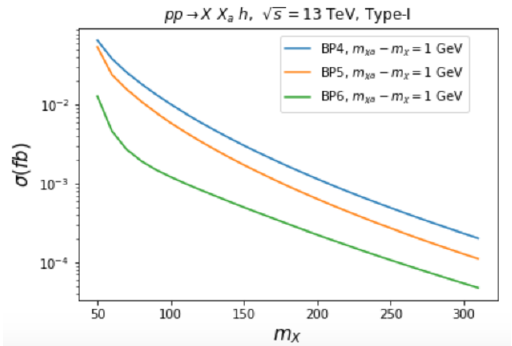
Figure 12 . Cross sections for (cid:31)(cid:31) a h (cid:12)nal state as a function of DM mass for benchmark points BP4, BP5 and BP6. The mass parameter m (cid:31) was varied such that the mass di(cid:11)erence between a (cid:31) a and (cid:31) was kept (cid:12)xed as shown in the